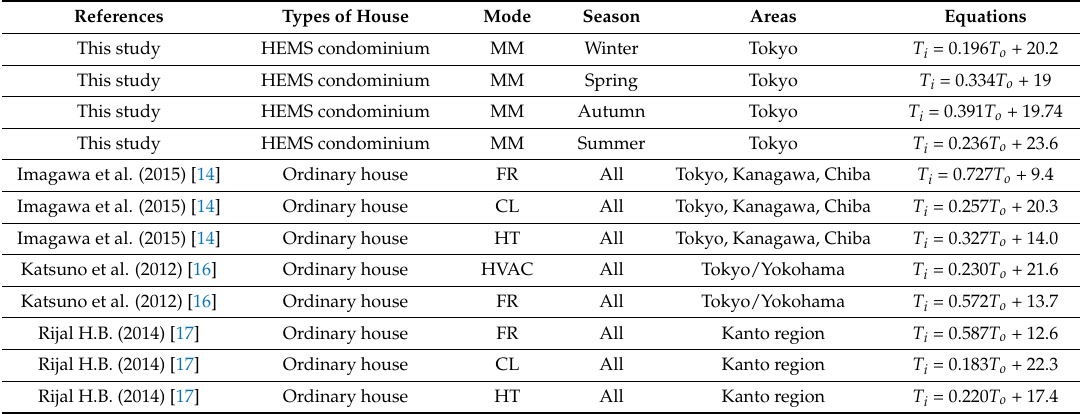
Figure 4. The relationship of indoor and outdoor air temperature in each season: ( a ) Winter, ( b ) Spring, ( c ) Autumn and ( d ) Summer. Table 1. Comparison with other